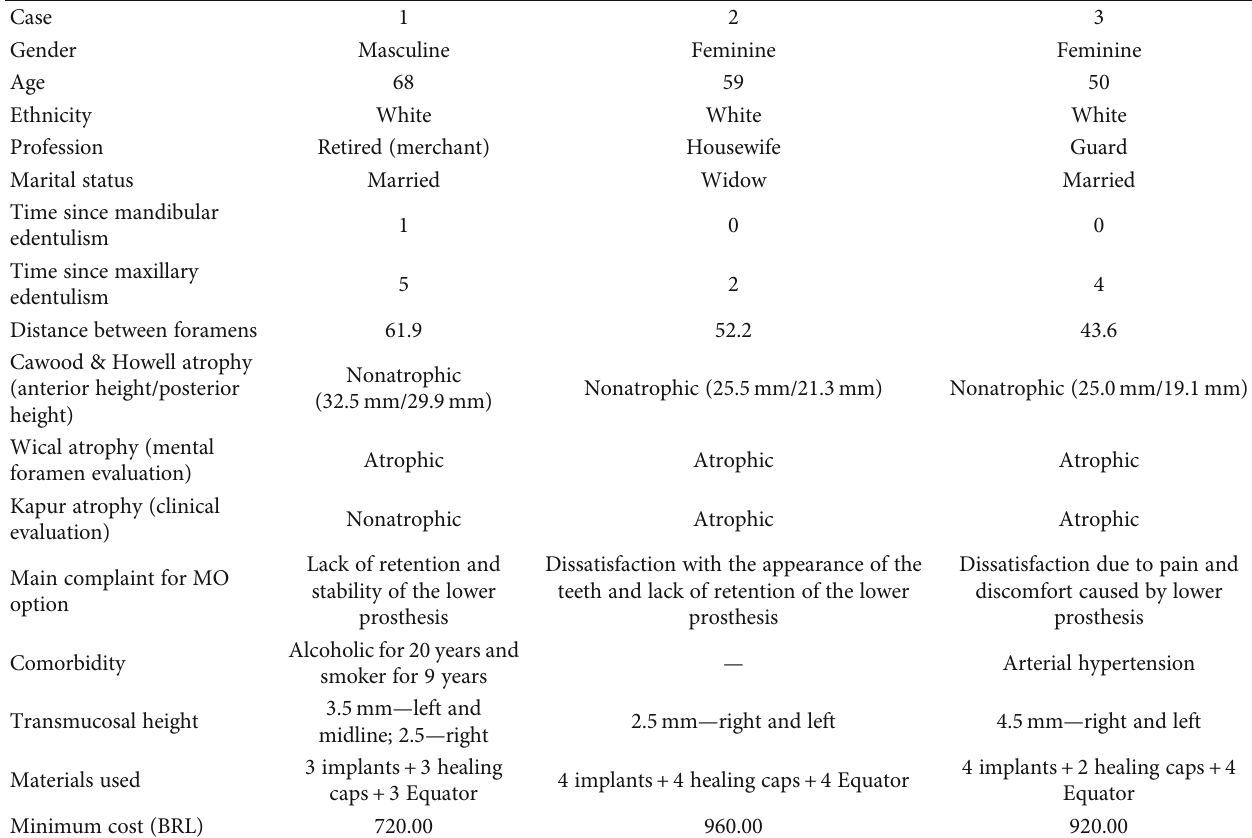
Table 1: Sociodemographic, clinical, radiographic, and fi nancial